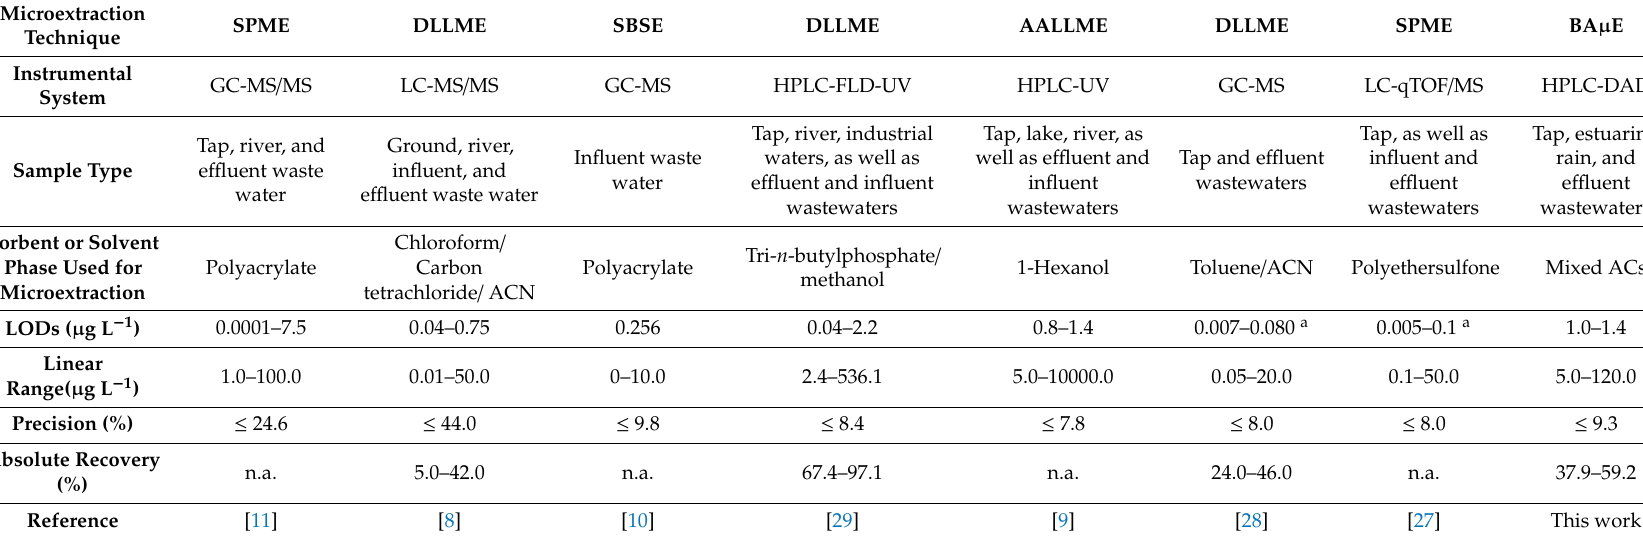
Table 2. Comparison of the proposed method with other microextraction-based approaches previously reported in the literature for the determination of benzotriazoles (BTRs), benzothiazoles (BTs), and benzenesulfonamide derivatives (BSDs) in environmental water matrices. Microextraction